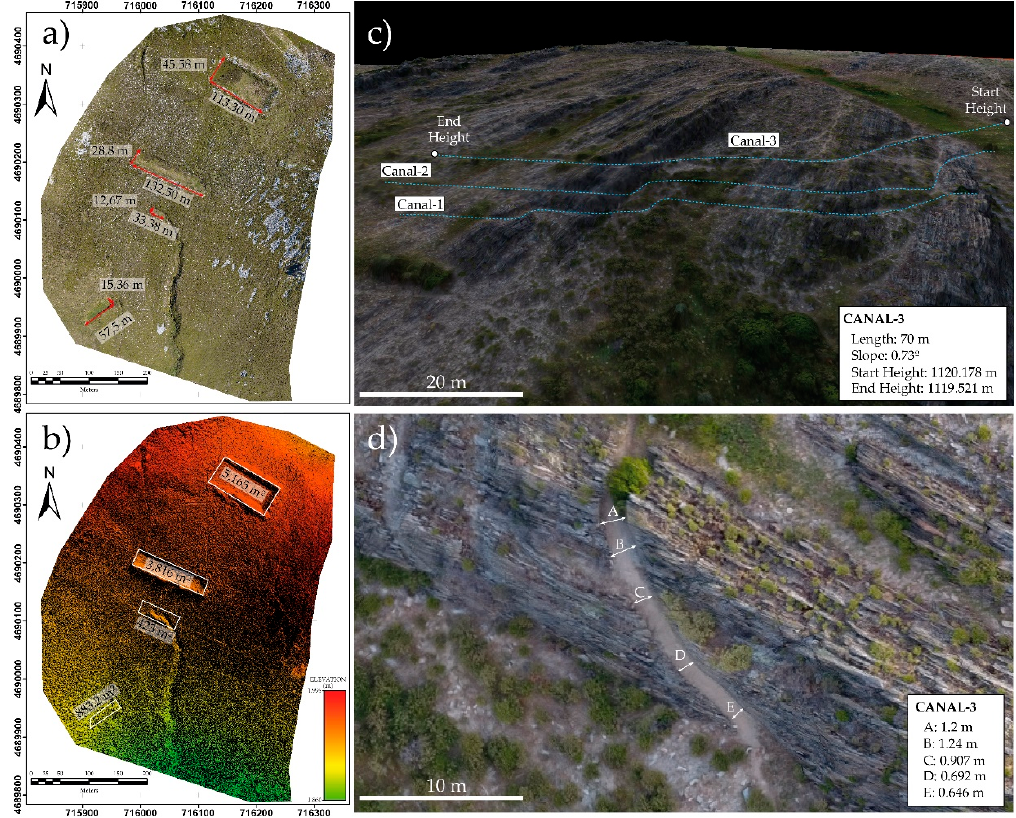
Figure 7. ( a ) Orthomosaic and ( b ) DSM from water reservoirs also called maseras (Model 5). 3D model of hydraulic infrastructure (Model 6). ( c ) Three supply canals excavated in slates. Water flow from right to left. Measurements of dimensions and characteristics of canal 3. ( d ) Differences in diameter measured in canal 3 along a curved section.